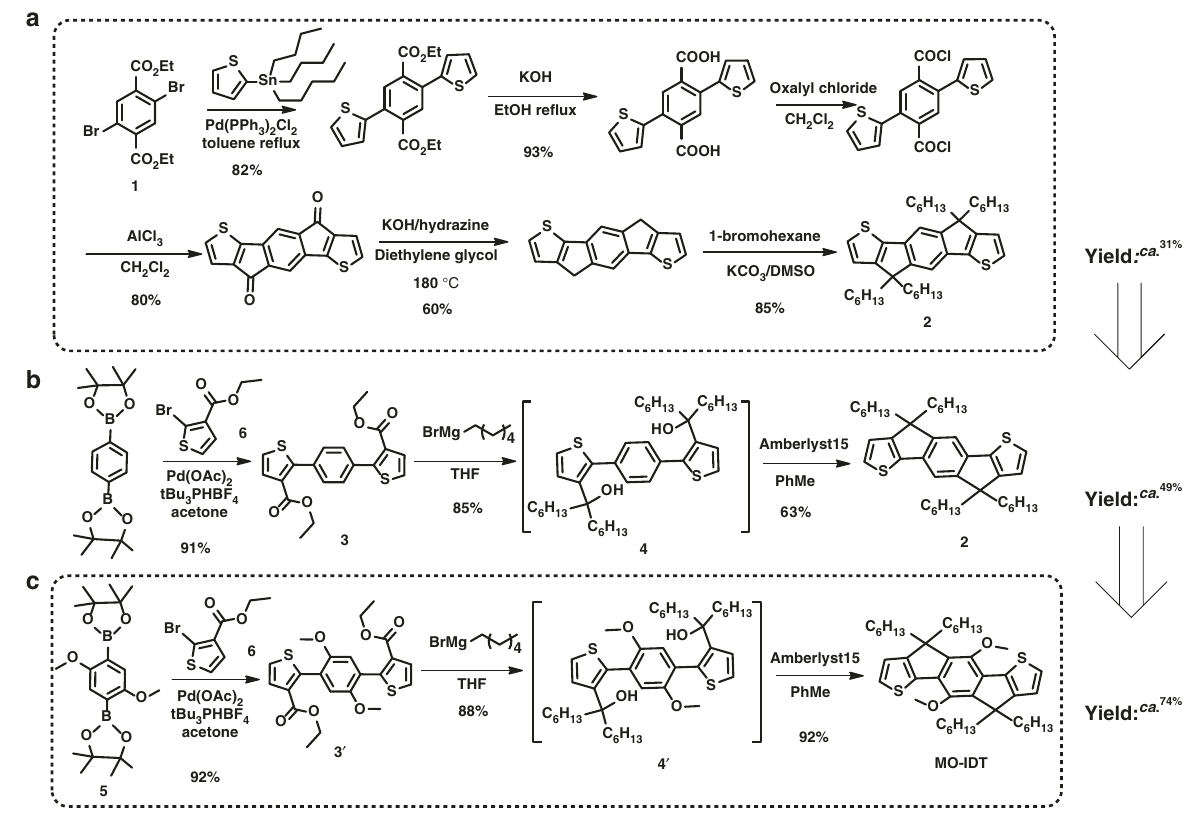
Fig. 1 Synthetic routes of the central fused ring units. a Synthetic route of the central fused ring core (Compound 2 ) of IDIC, b optimized synthetic route of Compound 2 and c synthetic route of the central fused ring core